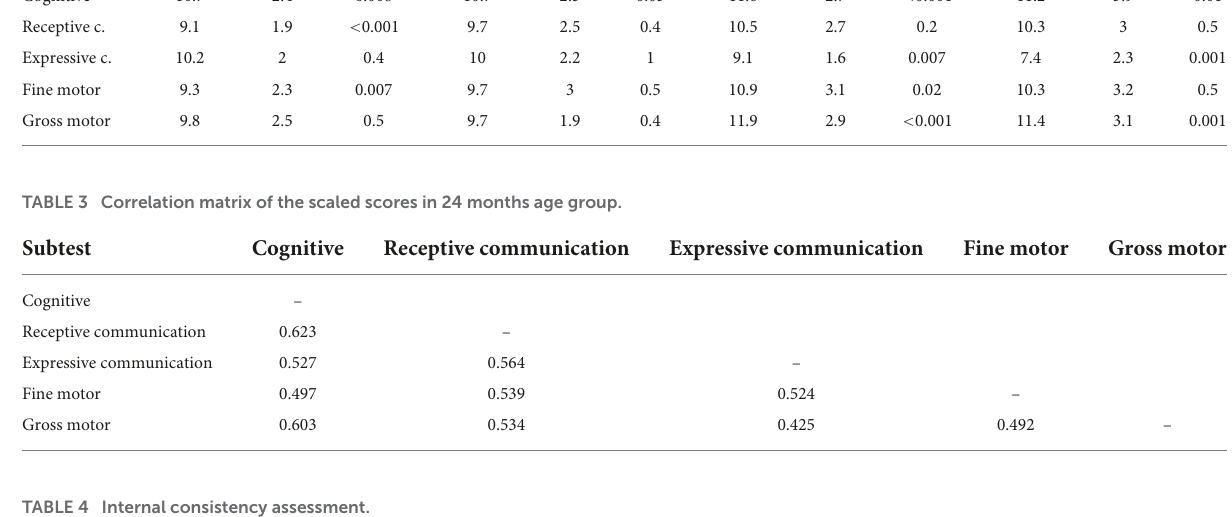
TABLE 4 Internal consistency assessment.